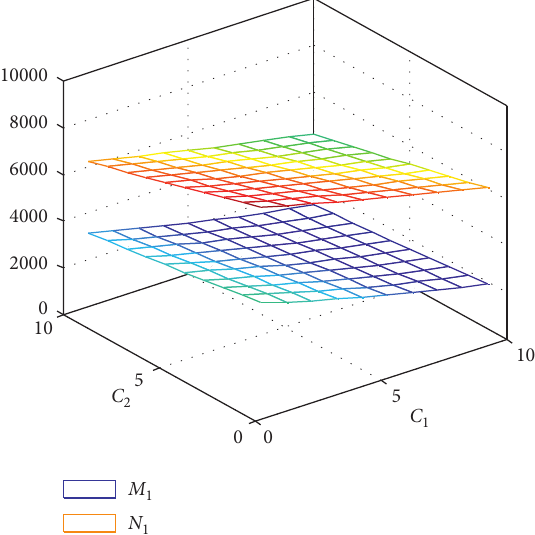
Figure 4: Total profits under decentralized and centralized deci- sion-making.